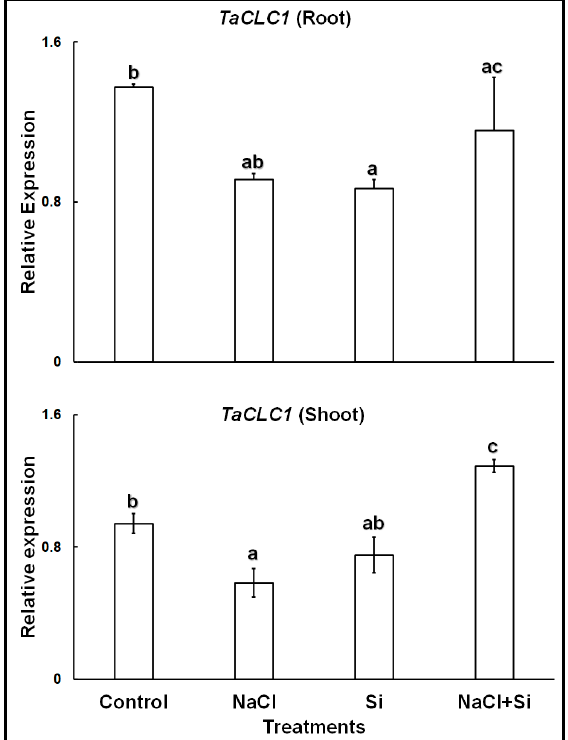
Figure 2. Relative expression of TaCLC1 in roots and shoots of wheat cv. Vinjette after 4 d of different treatments during the cultivation in nutrient solution. Different letters a–c indicate significant dif- ferences ( p ≤ 0.05) in treatment-dependent expression levels within each organ.